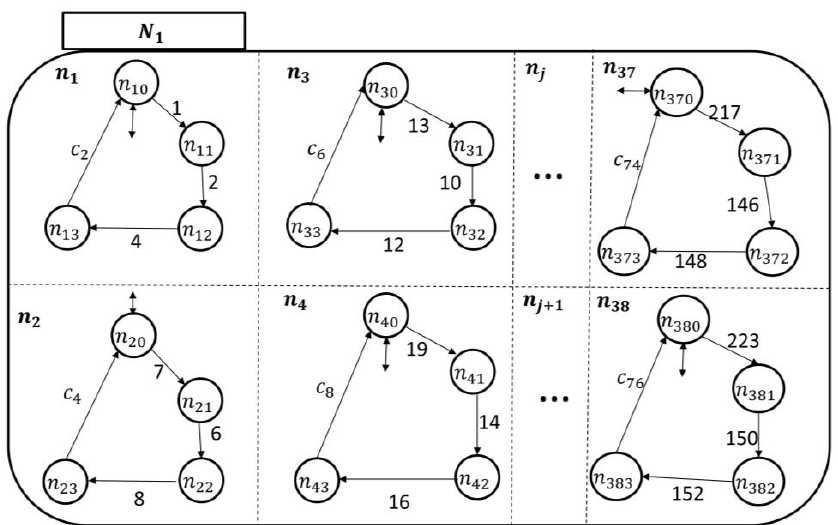
i state space topology with the nursing station, N i , expanded. Sensors 2018 , 18 , 2531